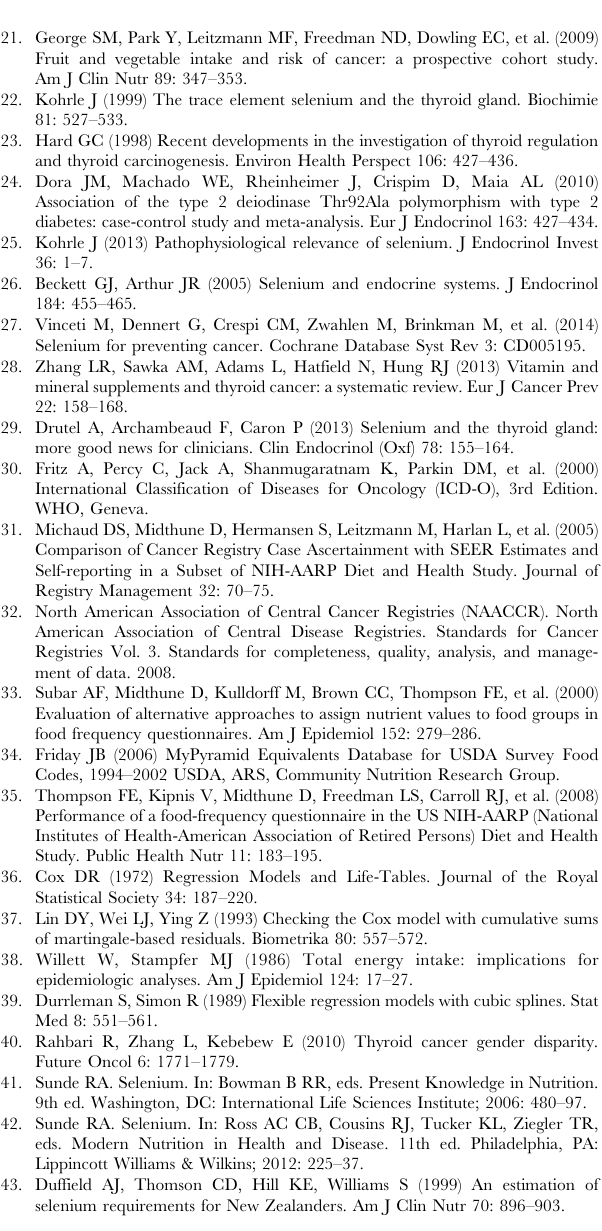
by quintile of micronutrient intake among men in The NIH-AARP Diet and Health Study. Table S5 Hazard Ratios (HRs) and corresponding 95% confidence intervals (CIs) for papillary thyroid cancer by quintile of micronutrient intake among women in The NIH-AARP Diet and Health Study. Table S6 Hazard Ratios (HRs) and corresponding 95% confidence intervals (CIs) for total thyroid cancer by quintile of micronutrient intake among men in The NIH- AARP Diet and Health Study. Table S7 Hazard Ratios (HRs) and corresponding 95% confidence intervals (CIs) for follicular thyroid cancer